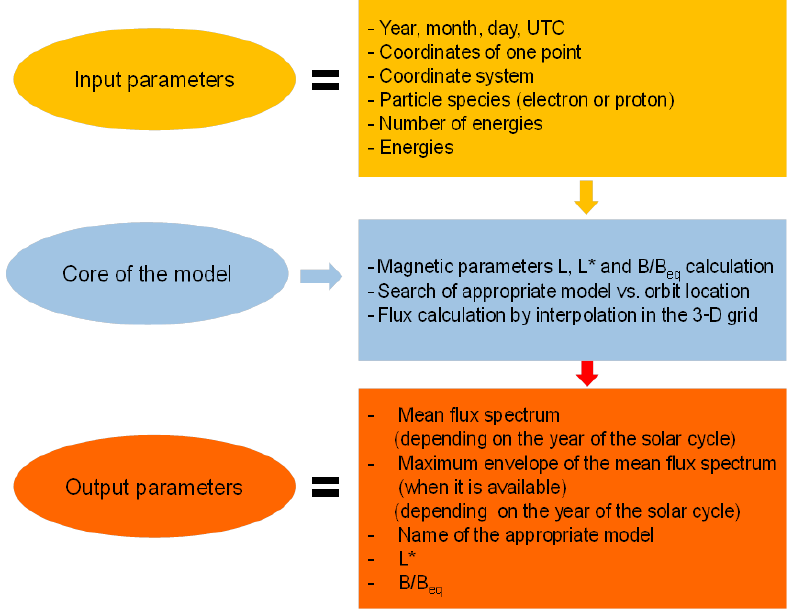
Figure 1. Input and output parameters of the GREEN